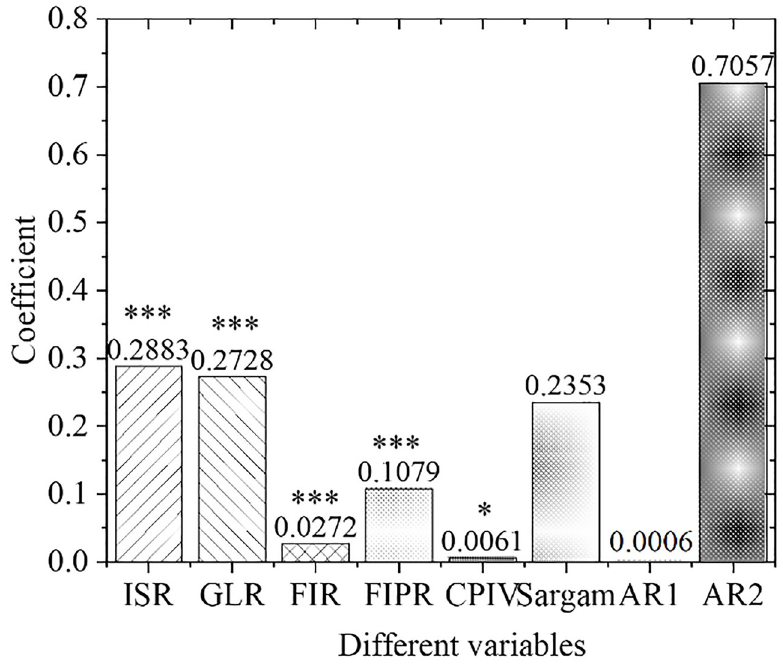
Fig 13. Robustness analysis results (empirical panel coefficient estimation of the whole country).